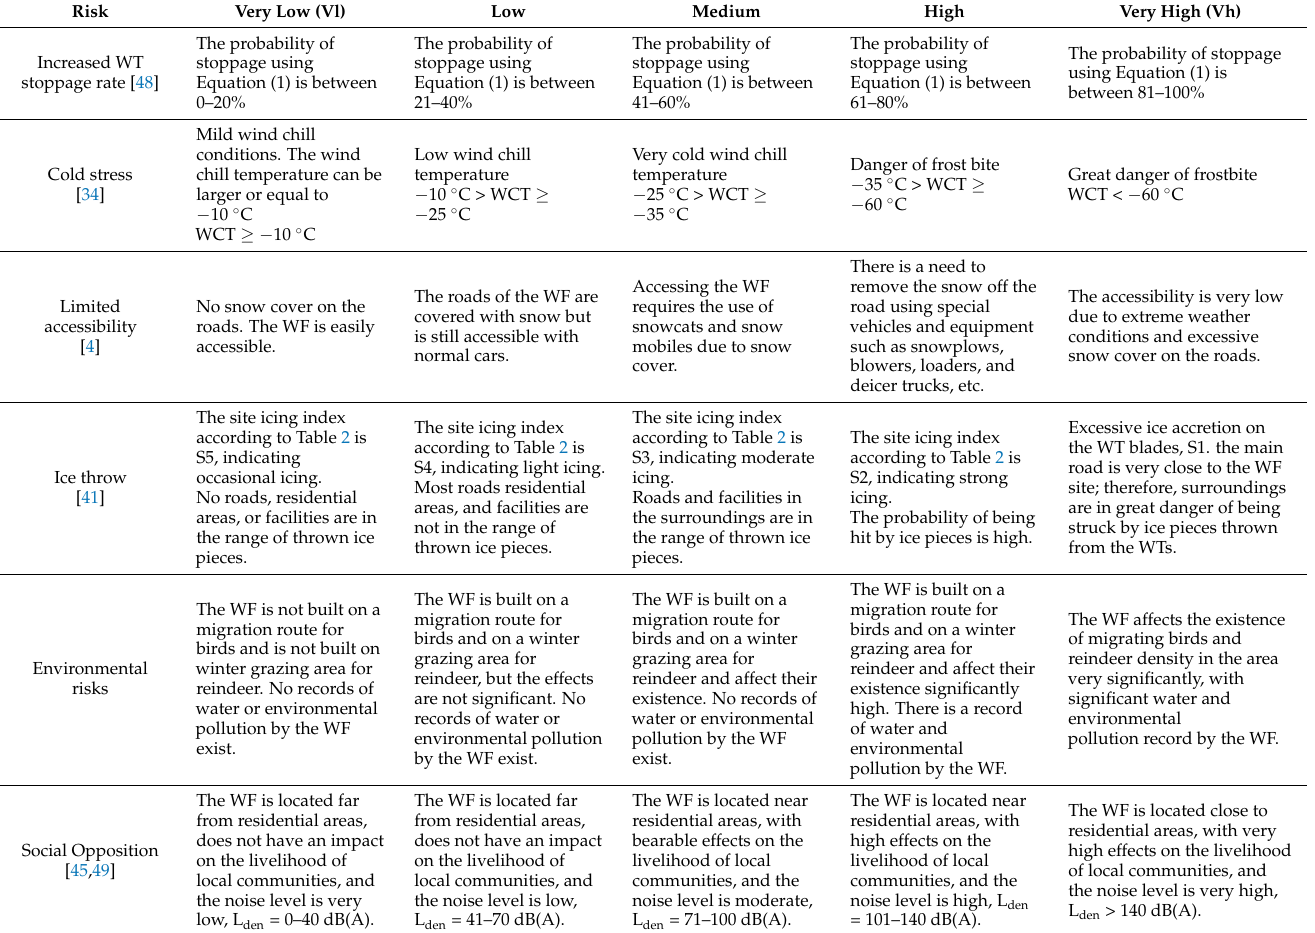
Table 4. Criteria for the probabilities of risks experienced by WFs in